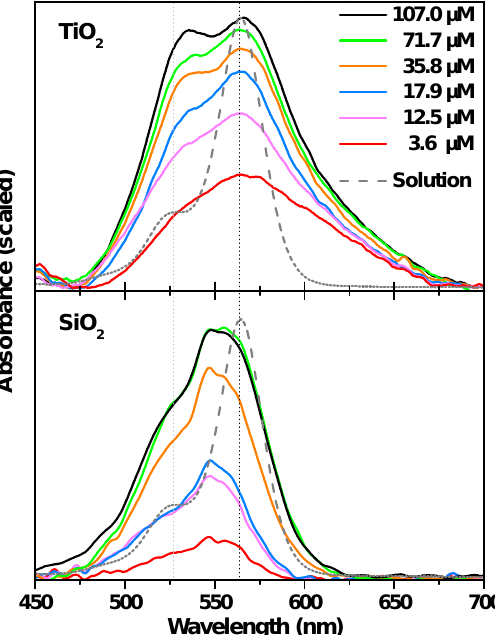
Figure 2. Absorption spectra for composite RosB/MO 2 thin films prepared by infiltration of CH 2 Cl 2 solutions at different concentrations. The infiltration time was 24 h in all cases. The corresponding spectrum in solution is plotted as dashed lines for the sake of